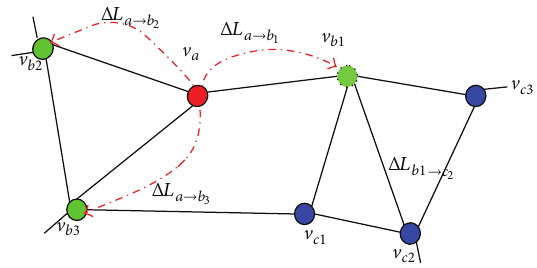
Figure 3: The first round of node failure and its load distribution.